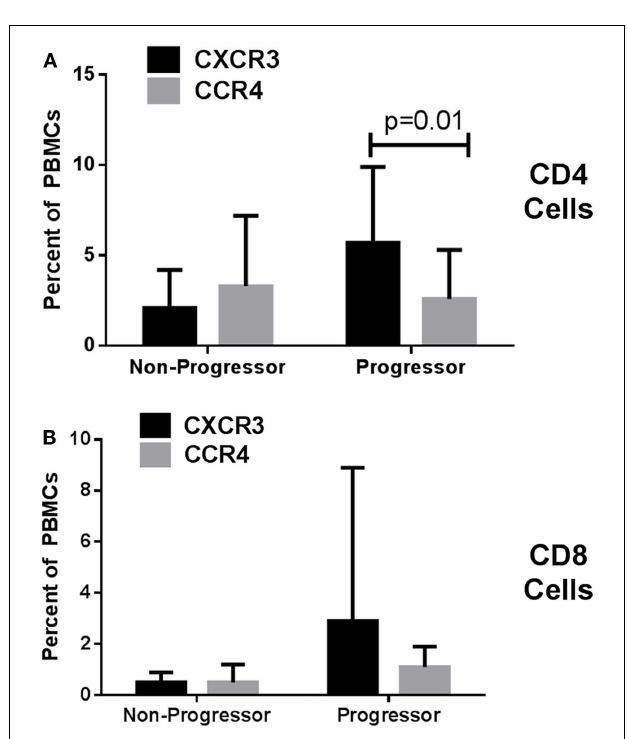
FIGURE 2 | Idiopathic pulmonary fibrosis patients have higher percentages of CXCR3 than CCR4 expressing CD4T cells . Mean values of each cell type were analyzed by unpaired T test adjusting for multiple comparisons using the Holm–Sidak method. (A) graphs CD4 cells while (B) graphs CD8